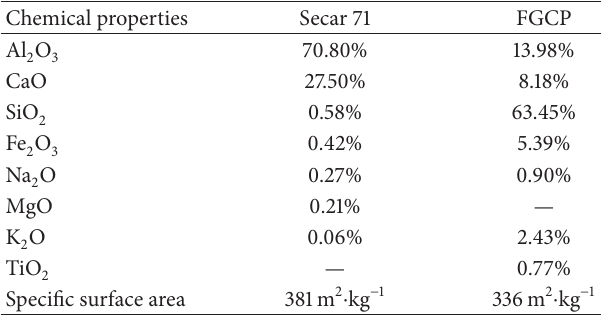
Table 2: Chemical properties of used aluminous cement and